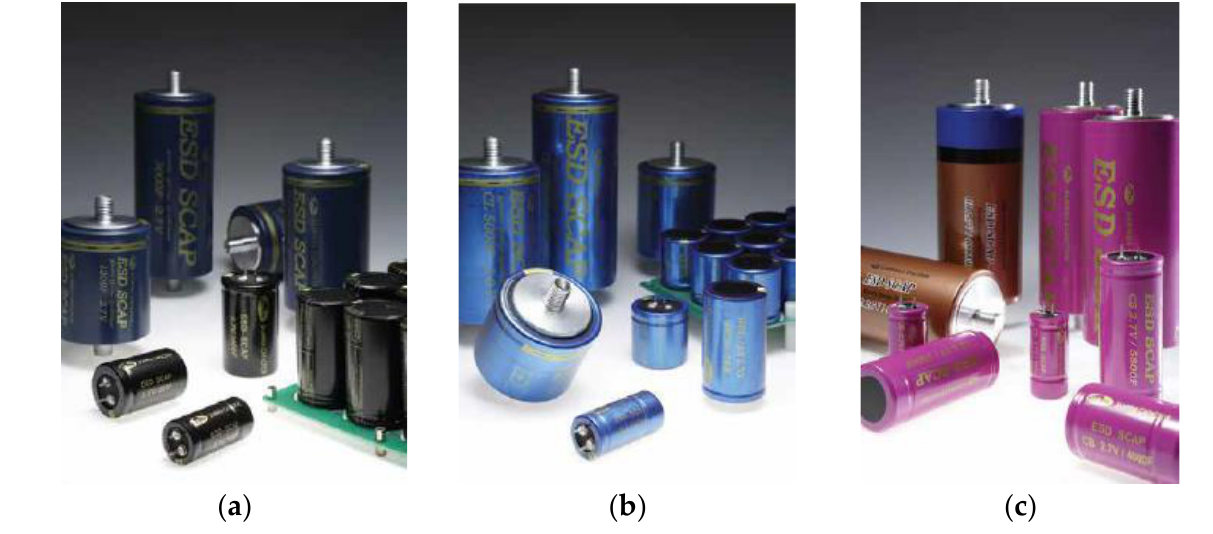
Figure 3. Commercial supercapacitor families from SAMWHA: ( a ) electric double-layer capacitors, ( b ) hybrid capacitors, ( c ) pseudocapacitors [18]. Table 2. Comparison of electric double-layer capacitors and other supercapacitor types [1 – 3] . Parameter